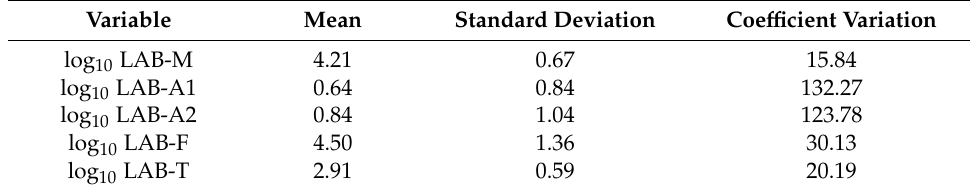
Table 1. Average counts (log 10 LAB) in the di ff erent samples analysed. Legend: LAB-M = counts of LAB in milk (CFU / mL), LAB-A1 = counts of LAB in the air from the milking parlour (CFU / 1000 L), LAB-A2 = counts of LAB in the air from the livestock housing (CFU / 1000 L), LAB-F = counts of LAB in the feed (CFU / g) and LAB-T = counts of LAB on the surface of teats (CFU / wipe). Variable Mean Standard Deviation Coe ffi cient Variation log 10 LAB-M